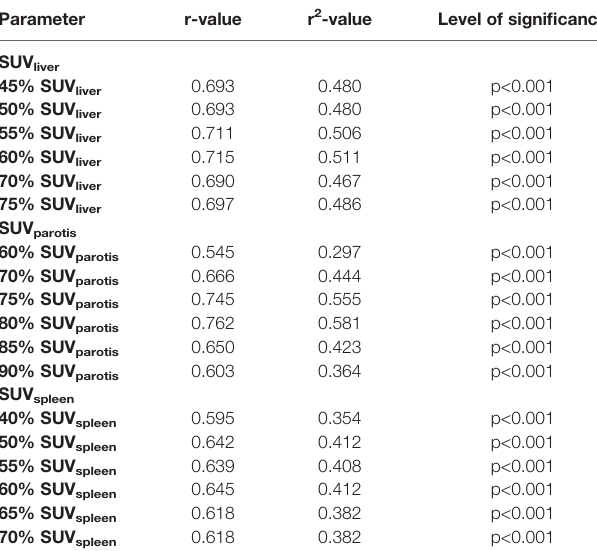
TABLE 3 | Background based volumetric correlations with SUV liver , SUV parotis and SUV spleen . Parameter